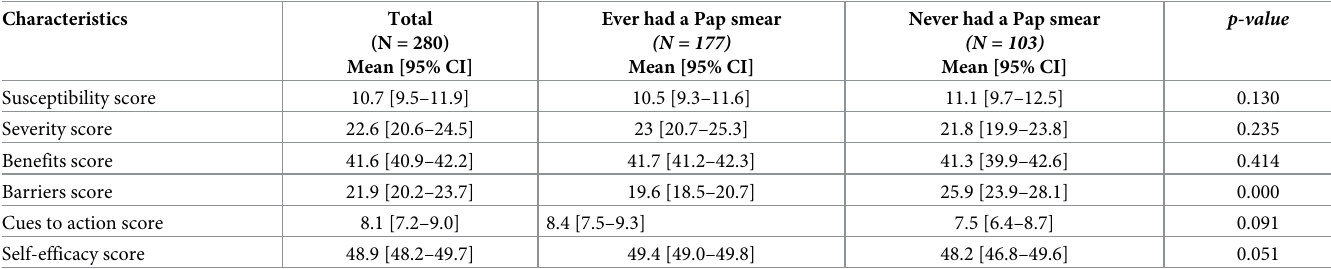
Table 2. Health Belief Model construct scores according to Pap smear history. Characteristics